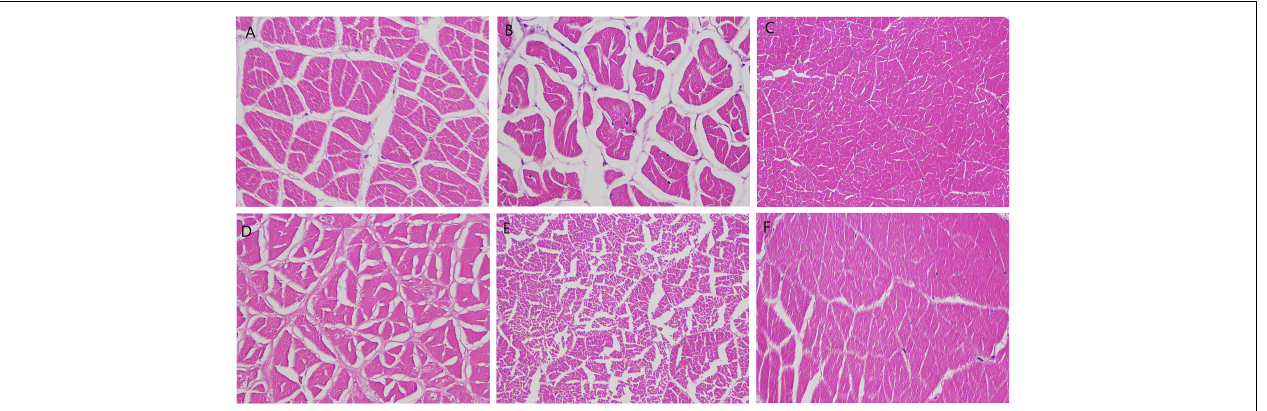
FIGURE 8 | Pathological analysis of muscle tissue of shrimps challenged with Vibrio parahaemolyticus . The shrimps were injected at the muscle between the 5th and 6th uromere with 1 mL of 17SZ and DH82 and the same volume of the mixture (1:1) of 17SZ and DH82. The muscle sections were performed using H&E staining and imaged by brightfield microscope with magnification of 400 times. Panel (A) is a medium dose of DH82 (10 7 CFU/mL), panel (B) is a low dose of DH82 (10 6 CFU/mL); Panel (C) is a medium dose of 17SZ (10 7 CFU/mL), panel (D) is a low dose of 17SZ (10 6 CFU/mL); Panel (E) is the medium dose of the mixture of DH82 and 17SZ (1:1, 10 7 CFU/mL), panel (F) is a low dose of the mixture of DH82 and 17SZ (1:1, 10 7 CFU/mL).